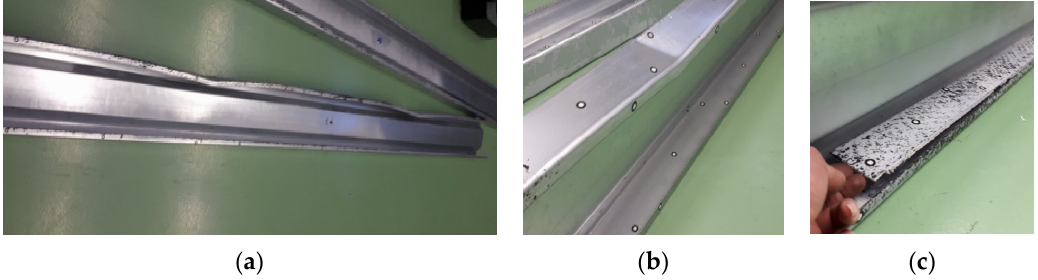
Figure 6. Form of sample failure mode: ( a ) local damage of top flange; ( b ) mixed failure mode: local damage of top flange and debonding of the CFRP tape; ( c ) debonding of the CFRP tape.